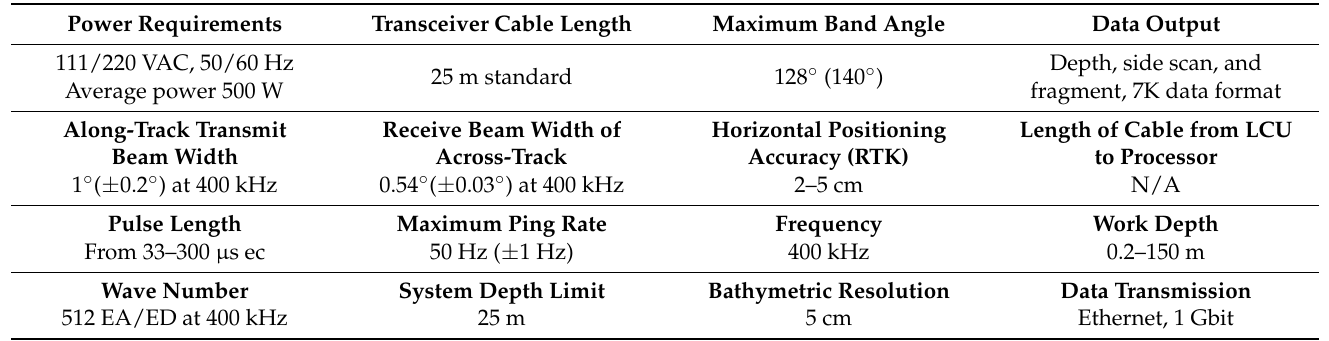
Table 2. The parameters of RESON SeaBat 7125 multibeam sounding system.